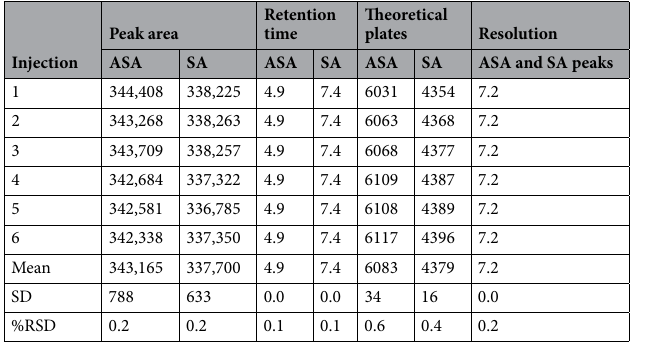
Table 1. System suitability and system precision